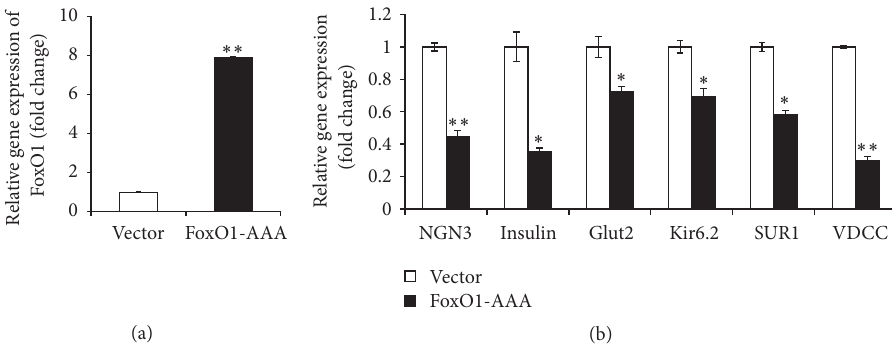
Figure 5: Constitutive activation of FoxO1 results in decrease of 𝛽 cell markers. (a) qRT-PCR analysis of FoxO1 mRNA levels in human pancreatic progenitor cells transfected with retrovirus expressing either vector or constitutively active FoxO1 (FoxO1 - AAA). Data were normalized against the level of GAPDH and expressed as fold change relative to vector (low panel). Values are means ± SEM of 4 independent experiments per each group. ∗∗ 𝑝 < 0.01 . (b) qRT-PCR analysis of 𝛽 cell markers in human pancreatic progenitor cells transfected with retrovirus expressing either vector or constitutively active FoxO1 (FoxO1 - AAA). Data were expressed as fold change relative to vector and are means ± SEM of 3 to 5 independent experiments per each group. ∗ or ∗∗ , 𝑝 < 0.05 or